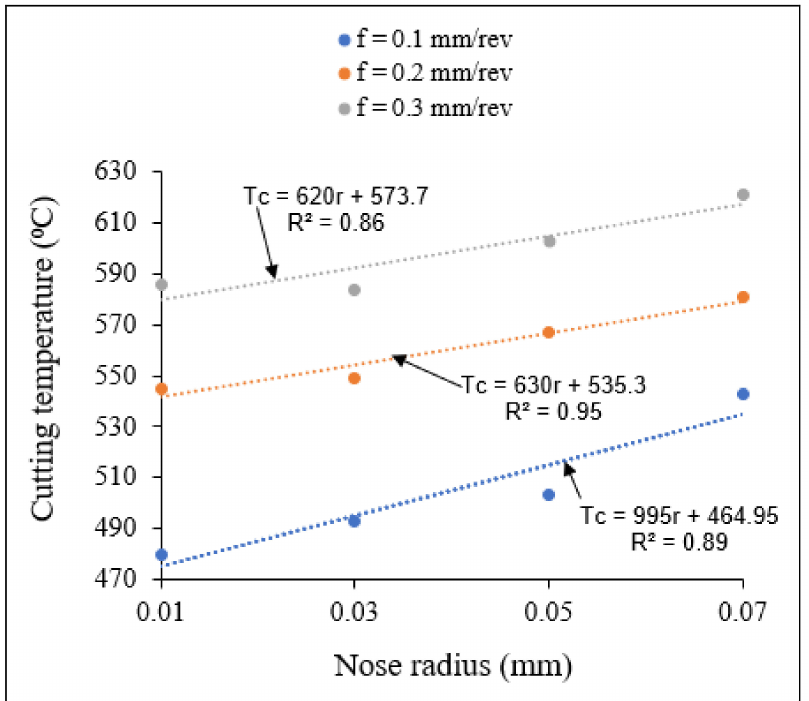
Figure 12. Variation of cutting temperature with small tool nose radius for different feed rates at V = 400 m/min, γ = 5 ◦ .